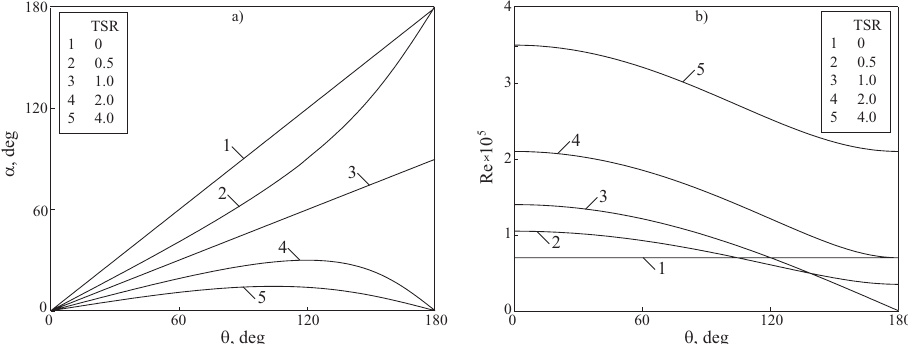
Figure 3. AOAs and Reynolds numbers experienced by airfoil at varying